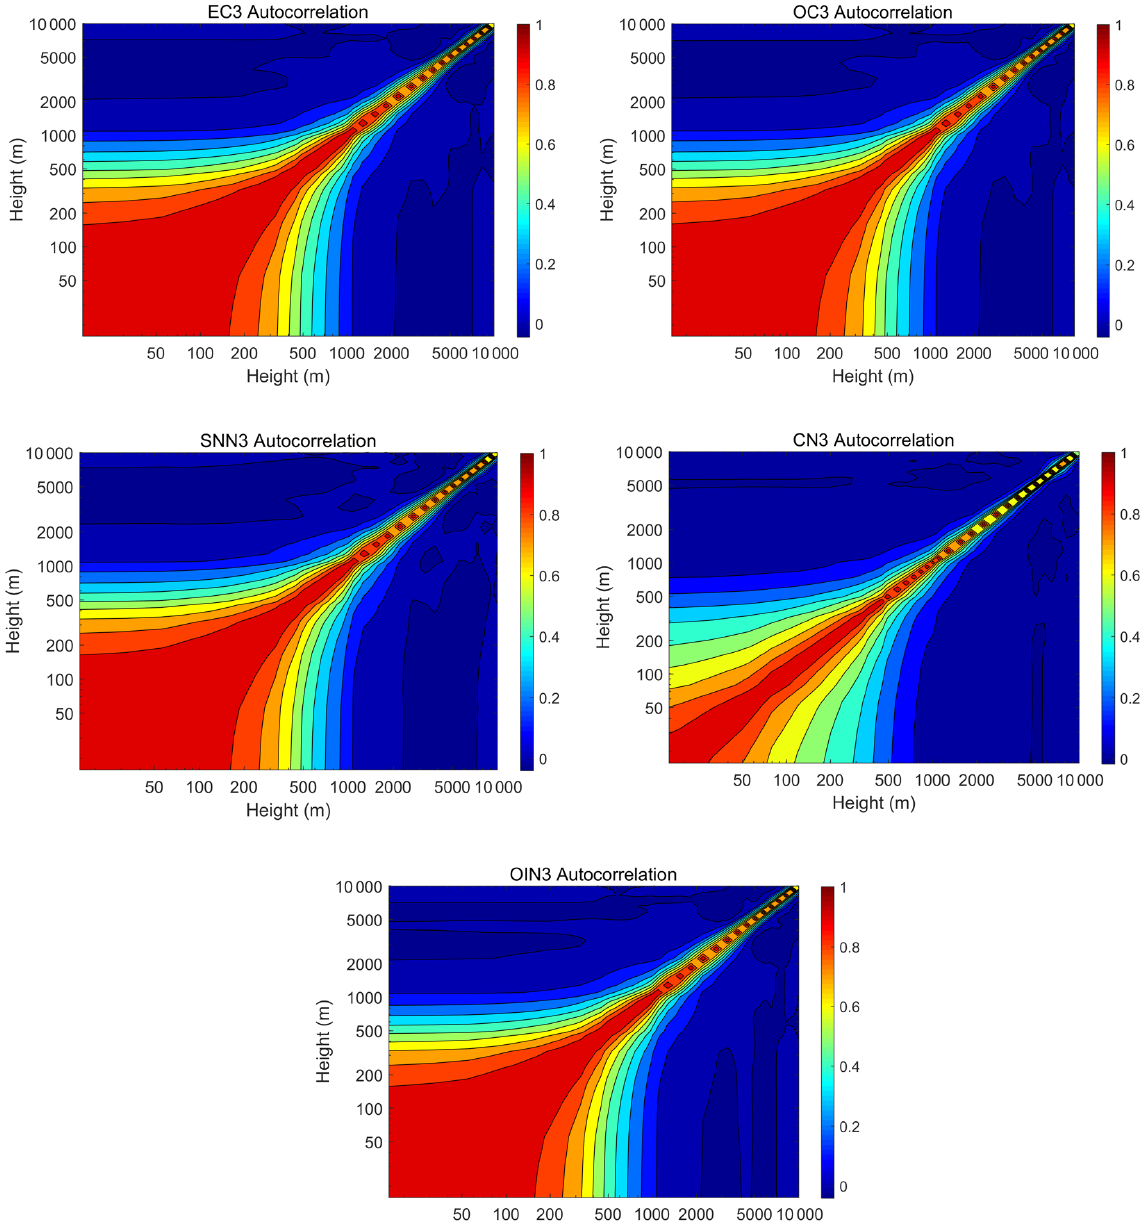
Figure 5. Vertical auto-correlations of background errors for aerosol state variables within the third size bin, i.e., EC3, OC3, SSN3, CN3, and OIN3. These statistics are directly estimated by the NMC method using WRF-Chem D02 outputs. Both axes are logarithmic and the contour interval is